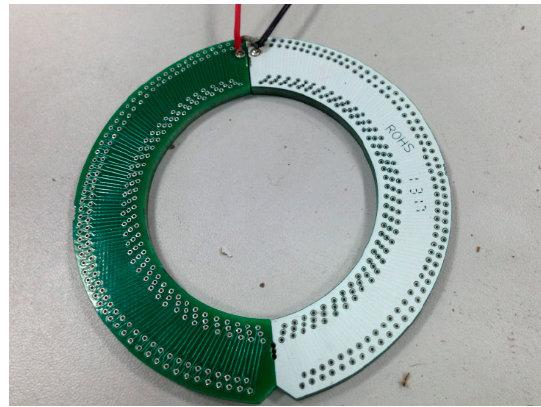
Figure 8. Physical picture of the designed Rogowski coil. Table 2. Geometric parameters of the PCB Rogowski coil .